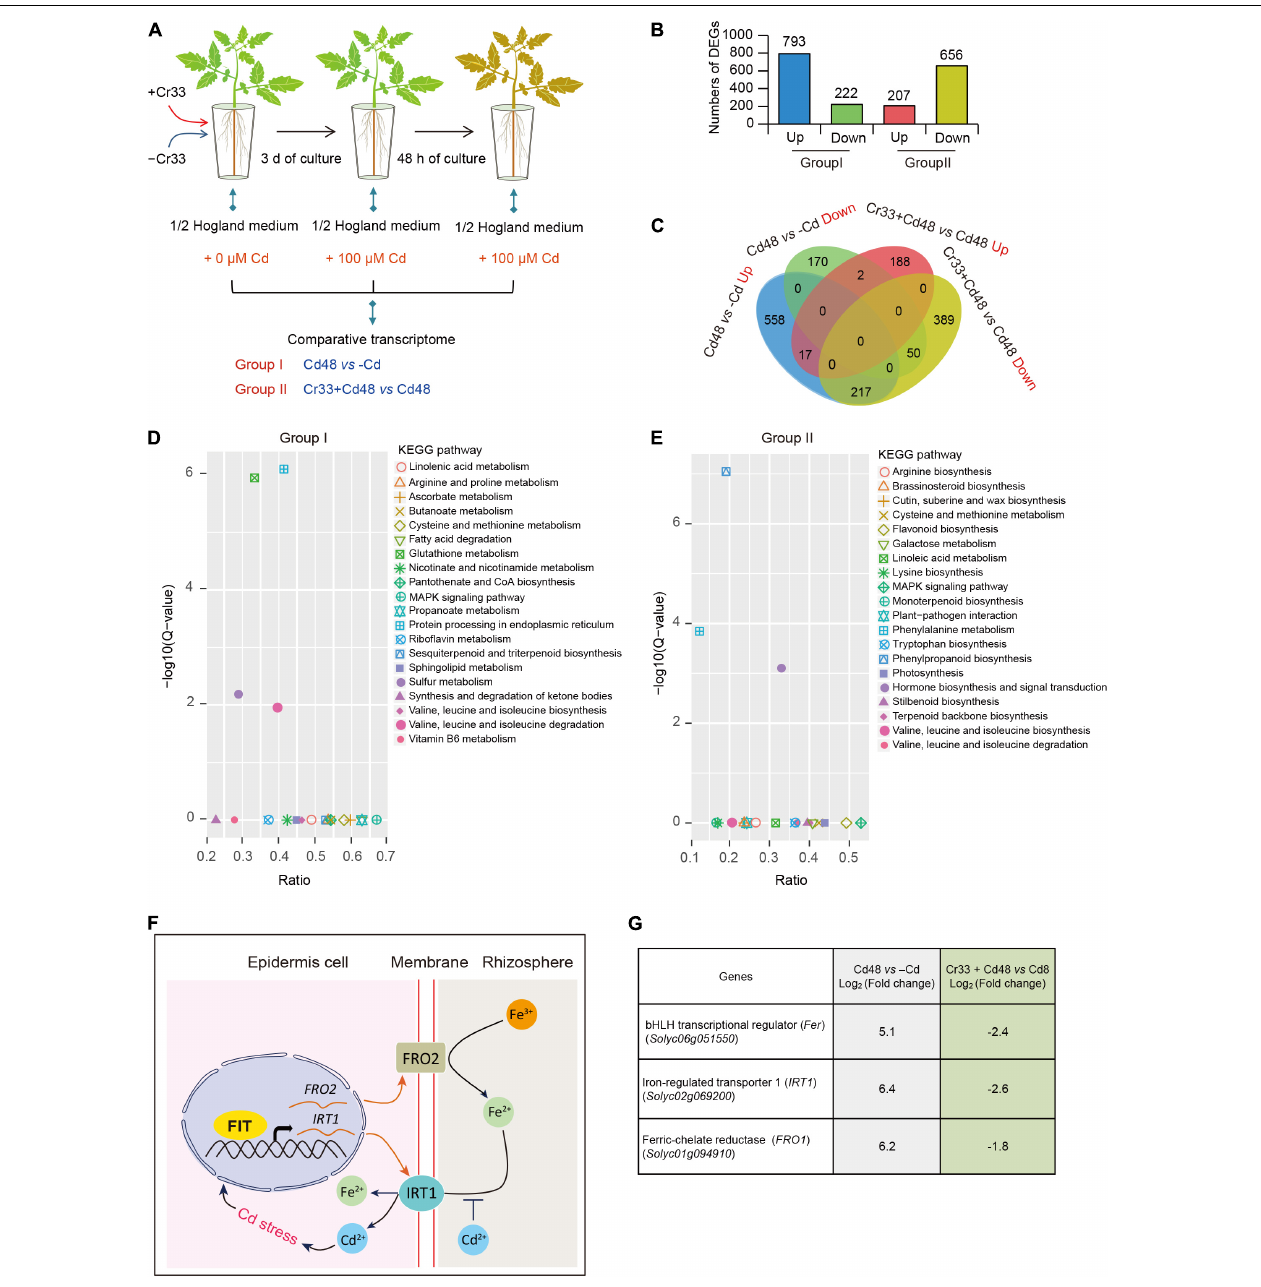
FIGURE 5 | Transcriptome analyses of L. fusiformis Cr33-inoculated roots in response to Cd stress. (A) Three-week-old tomato plants cultured in the split-root systems were inoculated with or without Cr33 for 3 d. Then, these plants were exposed to 100 µ M Cd with or without Cr33 for 48 h. Total RNA samples extracted from the treated roots were used for RNA-Seq analyses, including Group I (Cd48 vs. –Cd) and II (Cr33 + Cd48 vs. Cd48). (B) Numbers of DEGs in both Group I and II. (C) Venna diagram of shared and specific DEGS between the Group I and II. (D,E) KEGG analyses for up-regulated DEGs from the Group I and II. (F) A model for the Cd-activated Fe uptake leading to aggravate Cd toxicity in plants. Cd-induced expression of Fe uptake-related genes including FIT (a functional homolog of Fer ), IRT1, and FRO2 resulted in the increased Cd uptake in plants. (G) Expression profiles of Fer , IRT1, and FRO1 in both the Group I and